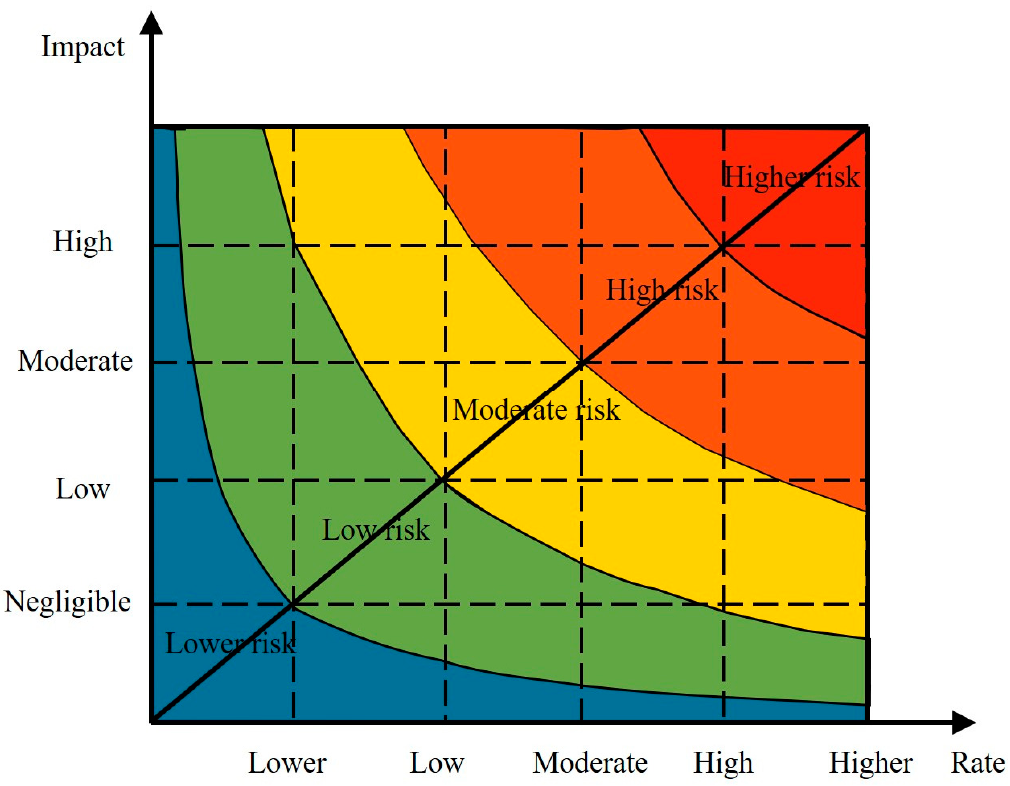
Figure 4. Risk probability—impact matrix schematic. Table 3. Main risk assessment of the project.